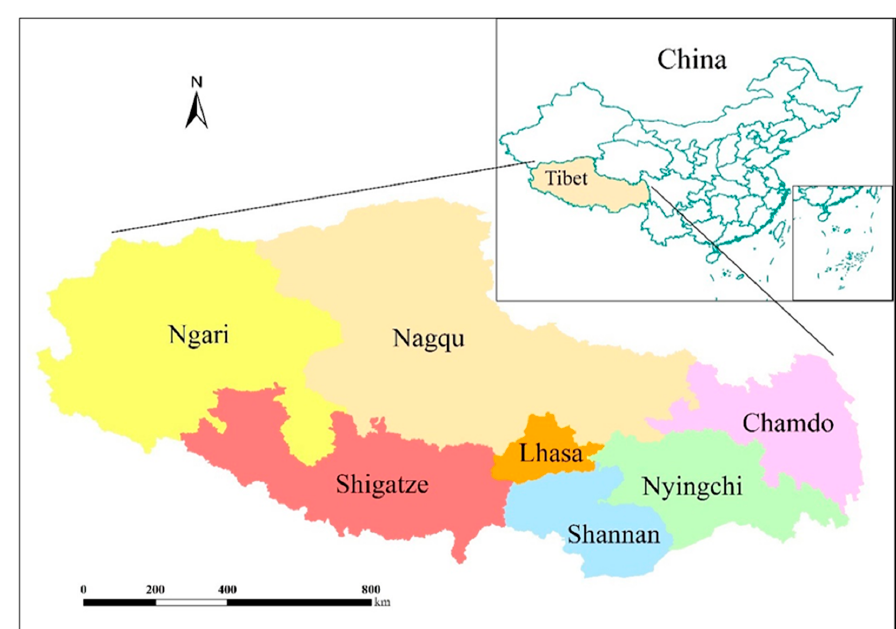
Figure 1. Study area of the Tibet Autonomous Region. Tibet is one of the five provincial autonomous regions that implements regional eth- nic autonomy in China. It is an ethnic autonomous region with Tibetans as the main body. Tibet has a total population of 3.37 million, of which 69% is located in rural areas. In 2017, the gross domestic production was CNY 131 billion. The primary, secondary, and tertiary industry percentages were 9.4%, 39.2%, and 51.4%, respectively. Tibet is in a tran- sition period from a traditional agrarian society to a modern industrialized one. With the implementation of the western development strategy, the Tibetan economy has devel- oped rapidly. Industrialization and urbanization have increased water utilization, which is important for the analysis of virtual water trade and pairwise relationships between socio-economic sectors.